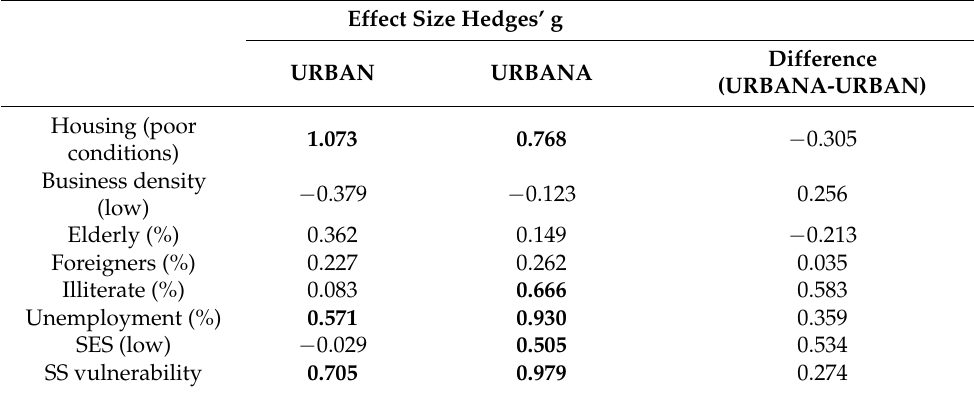
Table 4. Eligibility criteria compliance: differences between chosen and non-chosen areas. Effect sizes for each programme and differences between them (Hedges’ g). Effect Size Hedges’ g Difference URBAN URBANA